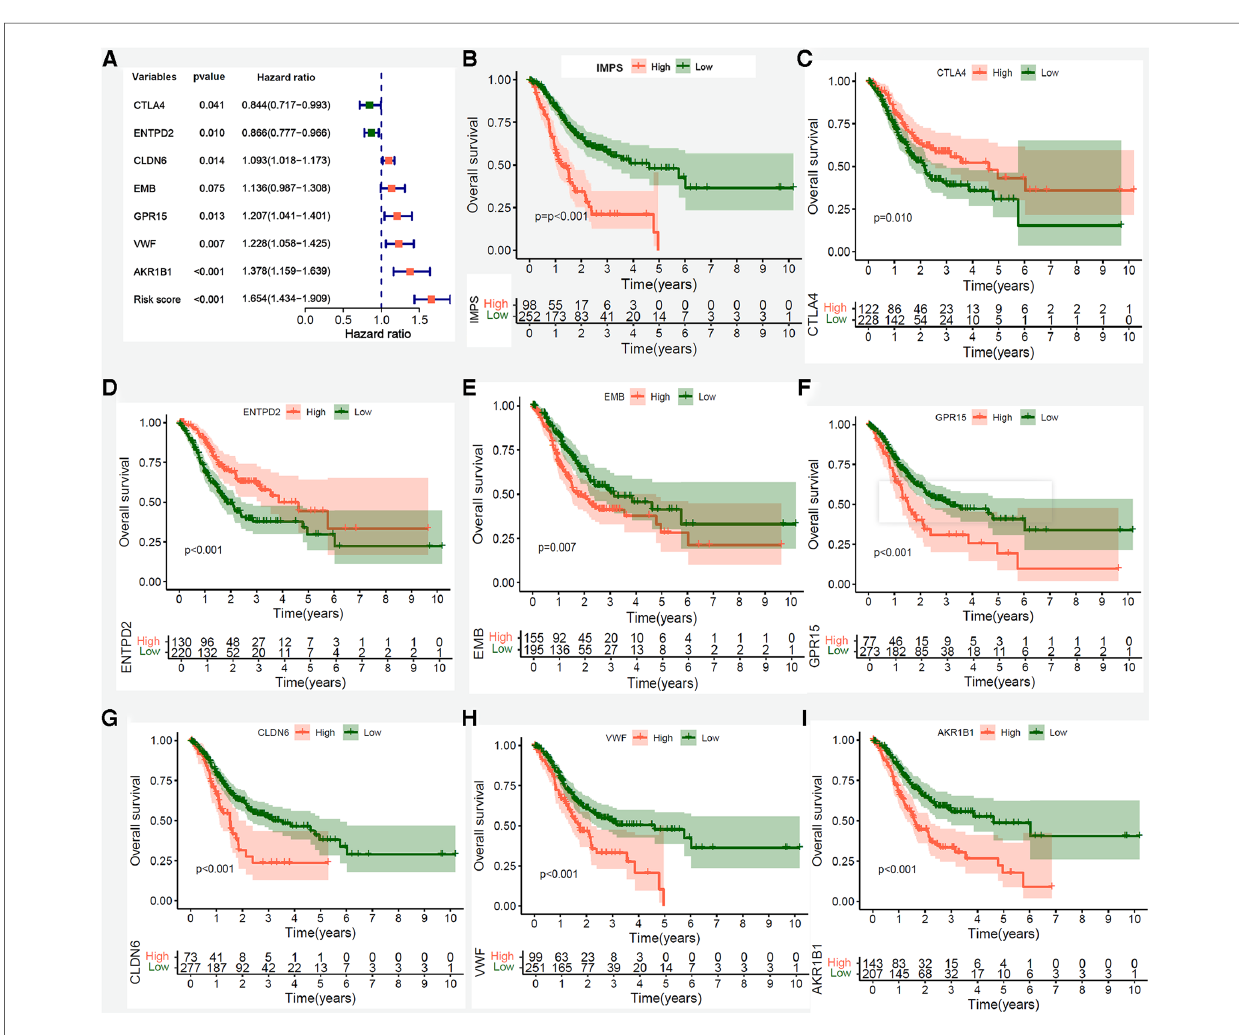
FIGURE 6 Kaplan-Meier survival analysis of IMPS and 7 prognostic hub genes in the entire TCGA-STAD cohort. ( A ) Univariate Cox forest-plot of IMPS and 7 prognostic hub genes. ( B – G ) Kaplan – Meier curve survival analysis of IMPS and 7 core prognostic gene, red line means high expression group, blue line means low expression group. ( B ) IMPS, ( C ) CTLA4, ( D ) ENTPD2, ( E ) EMB, ( F )GPR15, ( G ) CLDN6, ( H ) VWF and ( I )